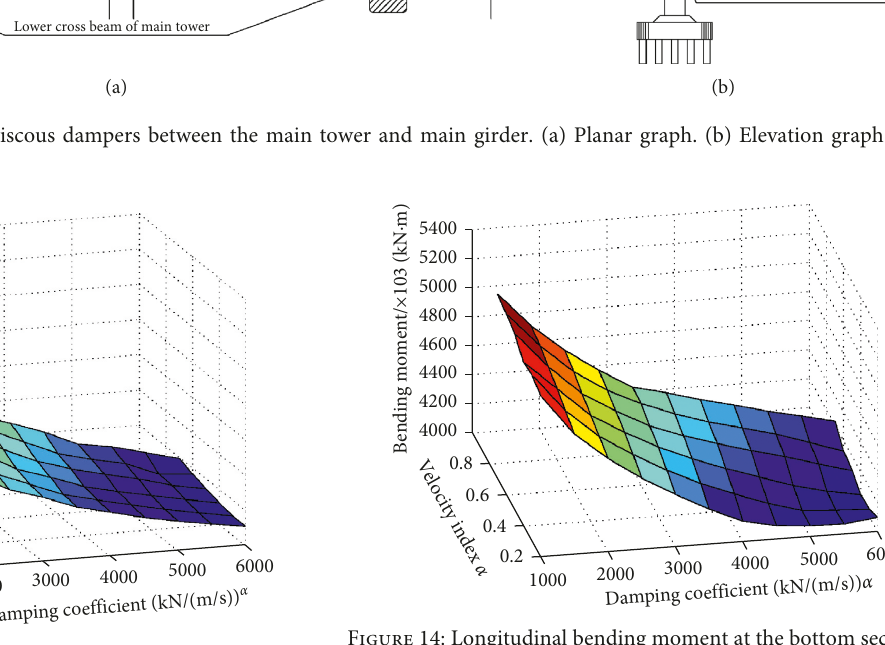
Figure 12: Longitudinal displacement of the end section of the main girder.